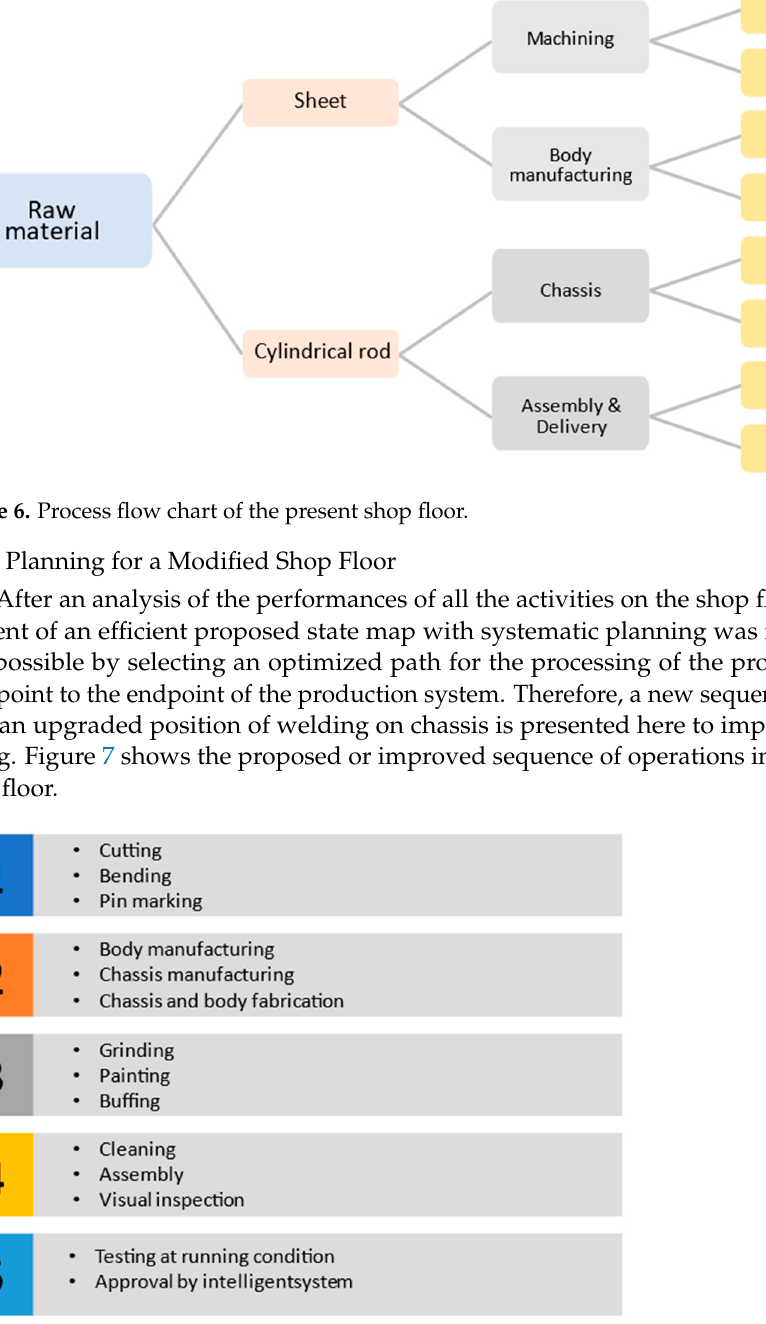
Figure 7. Proposed stepwise process flow chart.